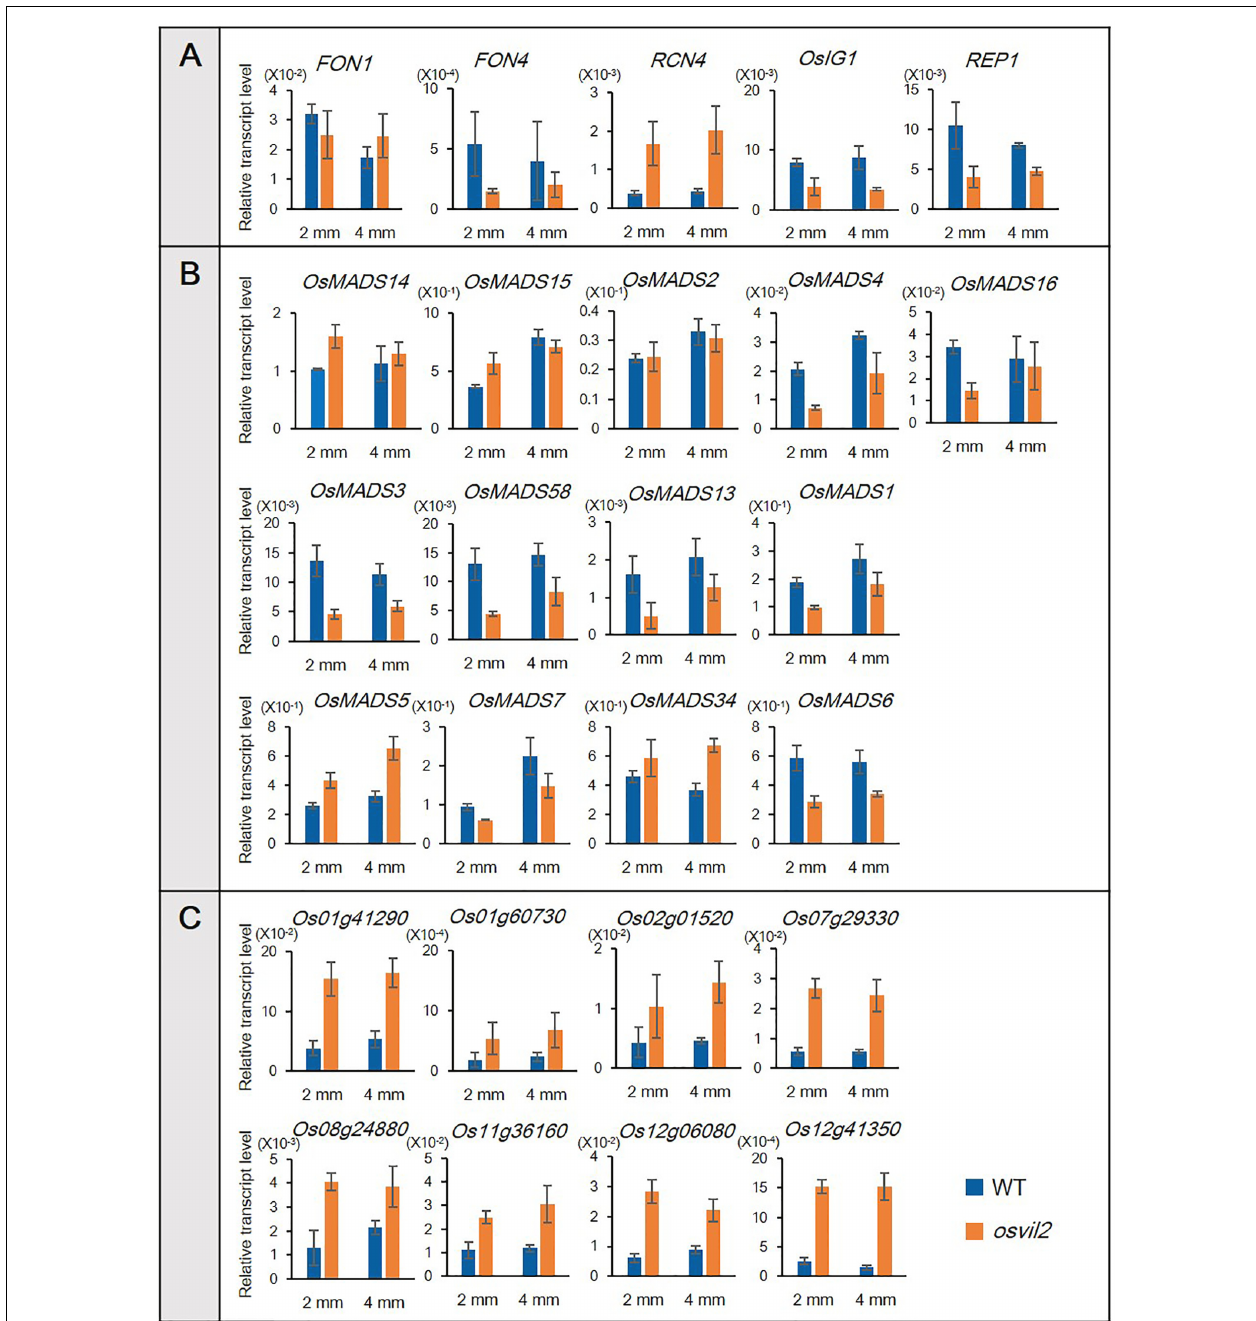
FIGURE 6 | Verification of RNA-sequencing results via qRT-PCR. Transcript levels are relative to Ubi1 . (A) qRT-PCR analysis of genes involved in spikelet development. (B) qRT-PCR analysis of MADS-box genes involved in floral organ development. (C) qRT-PCR analysis of upregulated genes previously identified in RNA-sequencing